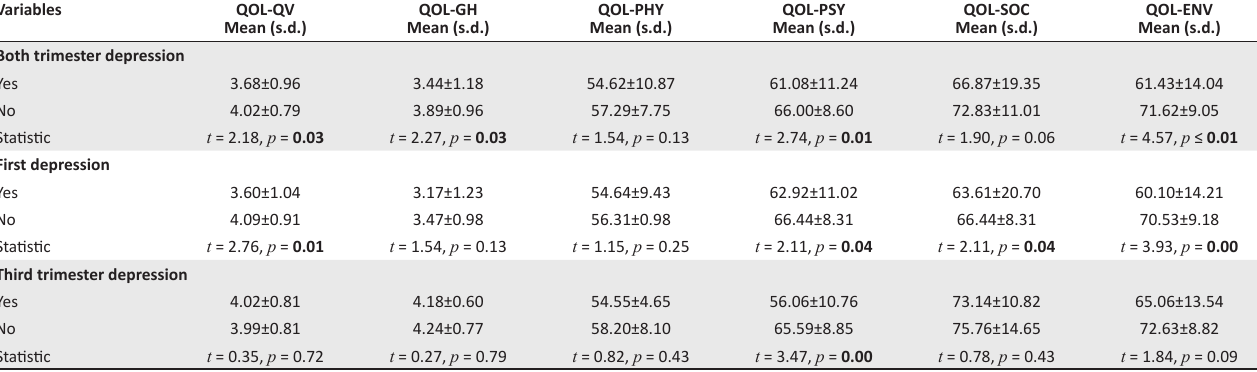
TABLE 9: Relationship between quality of life sociodemographic and depression in pregnancy.